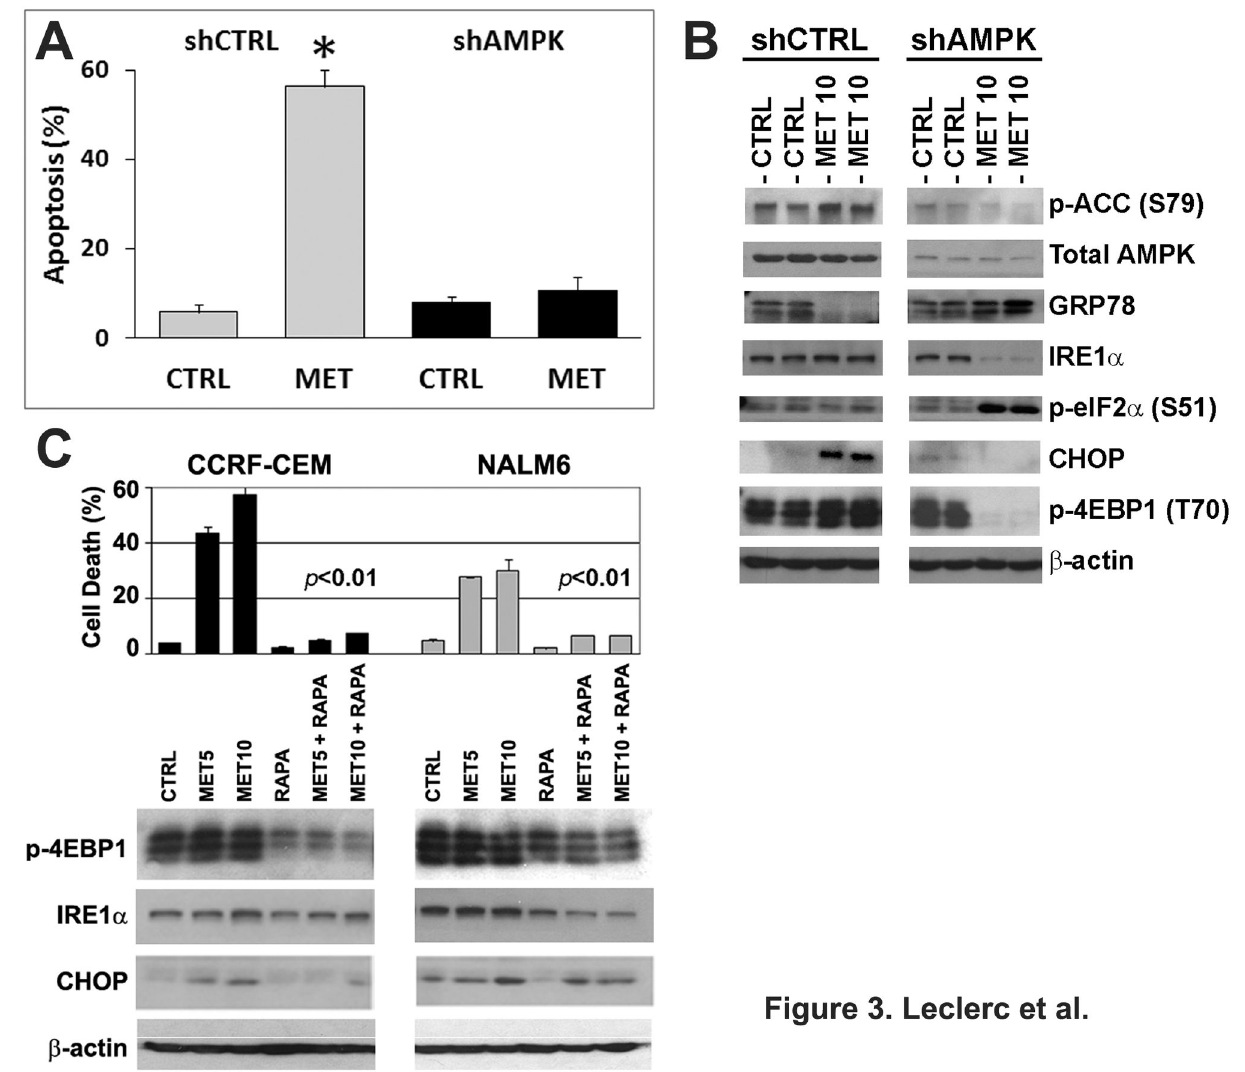
Figure 3. Inhibition of mTOR-dependent protein synthesis reverses metformin-induced cell death. A ) Apoptosis in CCRF- CEM cells expressing either scramble shRNA (shCTRL) or shRNA against AMPKα1 (shAMPK) treated with metformin (MET, 10 mM) for 48 h. B ) Immunoblotting of AMPK, Akt/mTOR, and ER stress/UPR signaling pathway proteins in the cells described in ( A